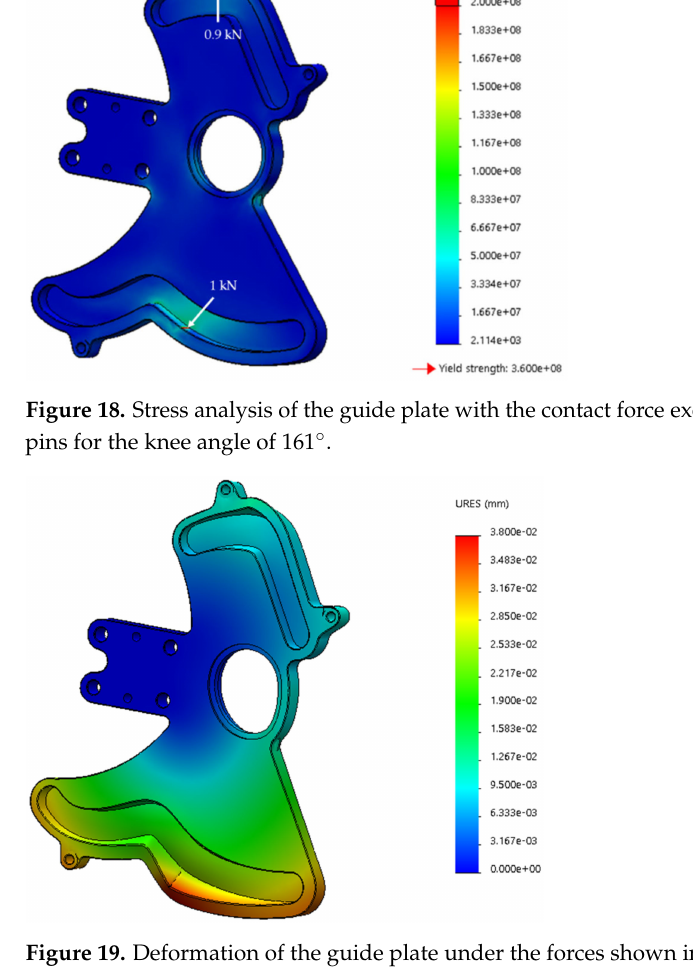
Figure 19. Deformation of the guide plate under the forces shown in Figure